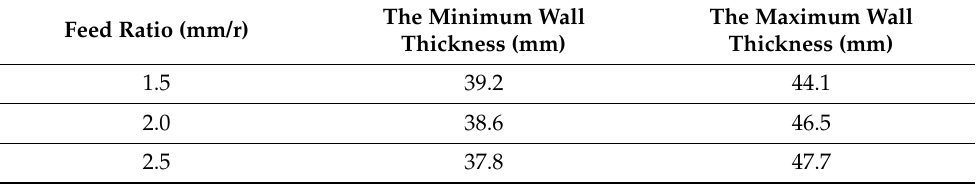
Table 3. The maximum and minimum wall thickness of cylinders after spinning at Feed ratio.